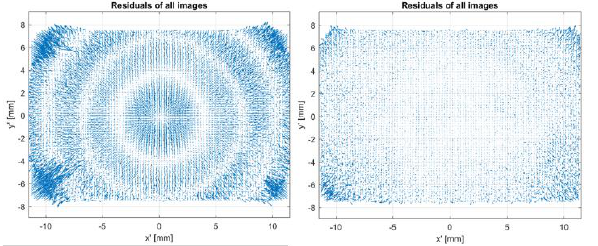
Figure 14. Residual plots from IAPG bundle adjustment with B and B+O for Canon (data set 5); vector scale 100.